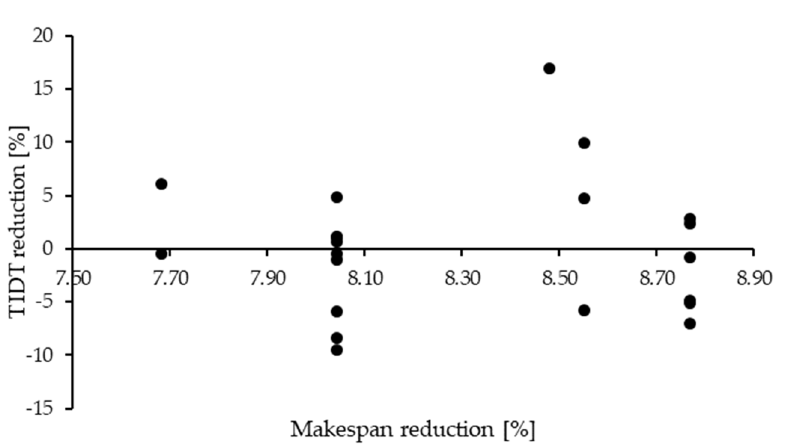
Figure 13. Performance comparison of particle swarm optimization (PSO) implemented by Hecker et al. [6] with modified PSO (MPSO) to optimize the makespan of problem II.